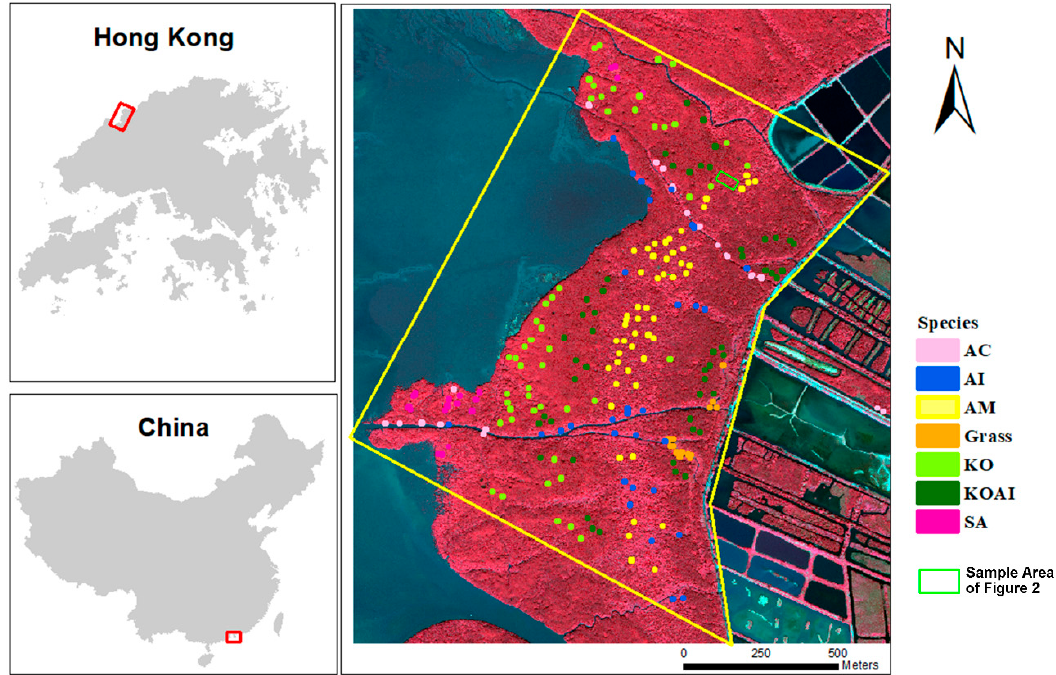
Figure 1. Map of the study area and the distribution of ground truth samples.